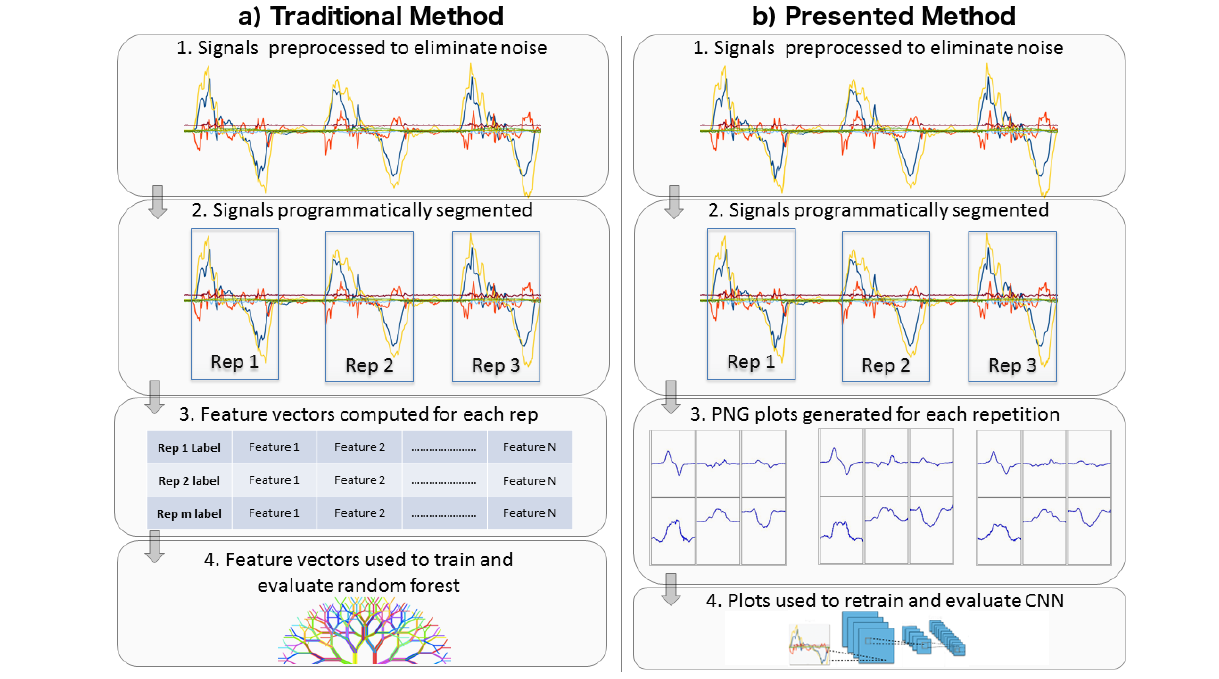
Figure 2. Depiction of the changes between traditional methods and the one presented in this paper, in particular steps 3 and